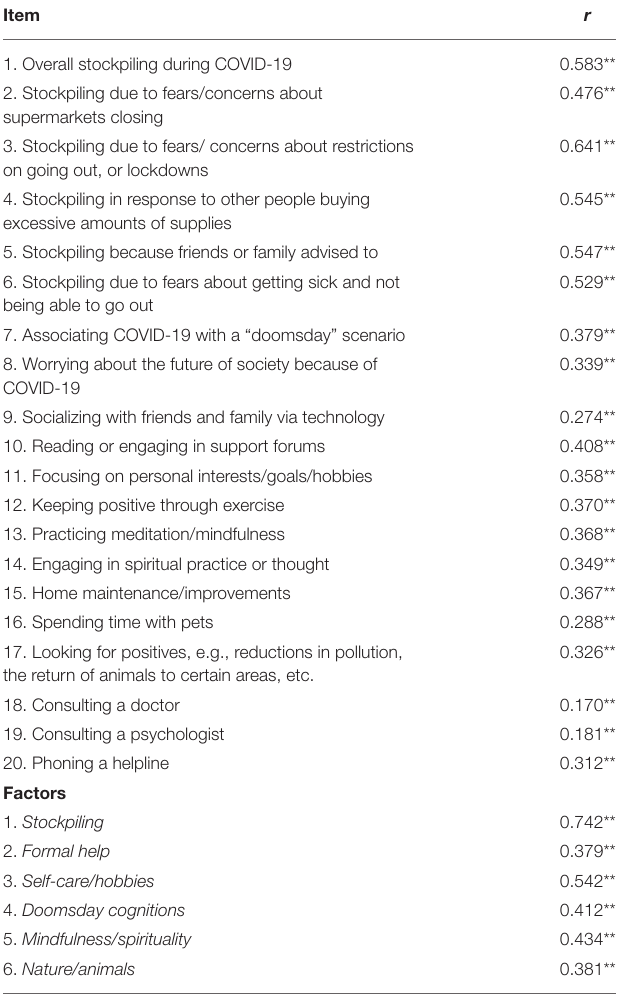
TABLE 4 | Spearman Rho’s correlations between each PCP-S item, factors and the total score.